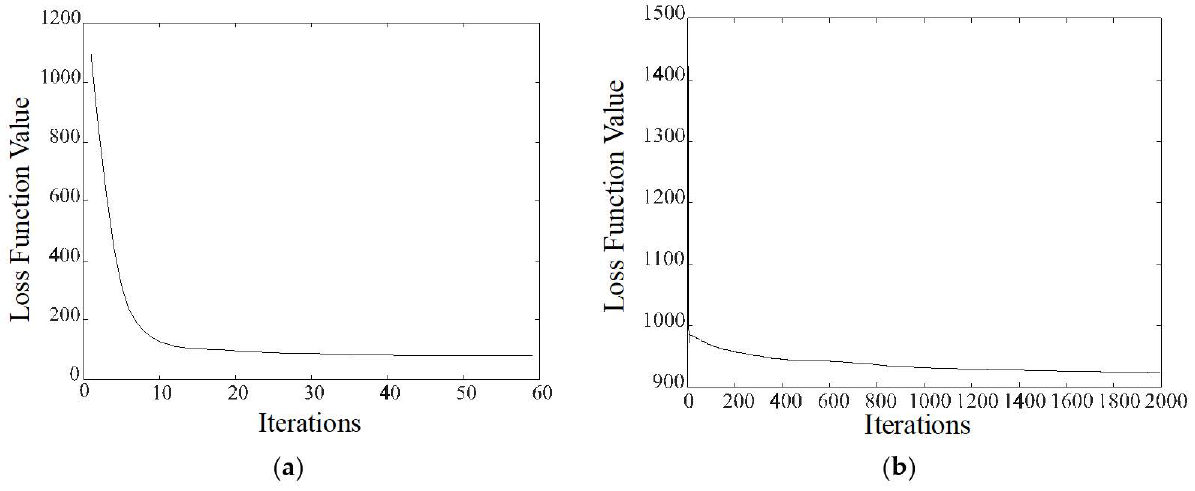
Figure 3. Comparison of loss function curve of steelmaking problem between ( a ) SVM-RL and ( b )